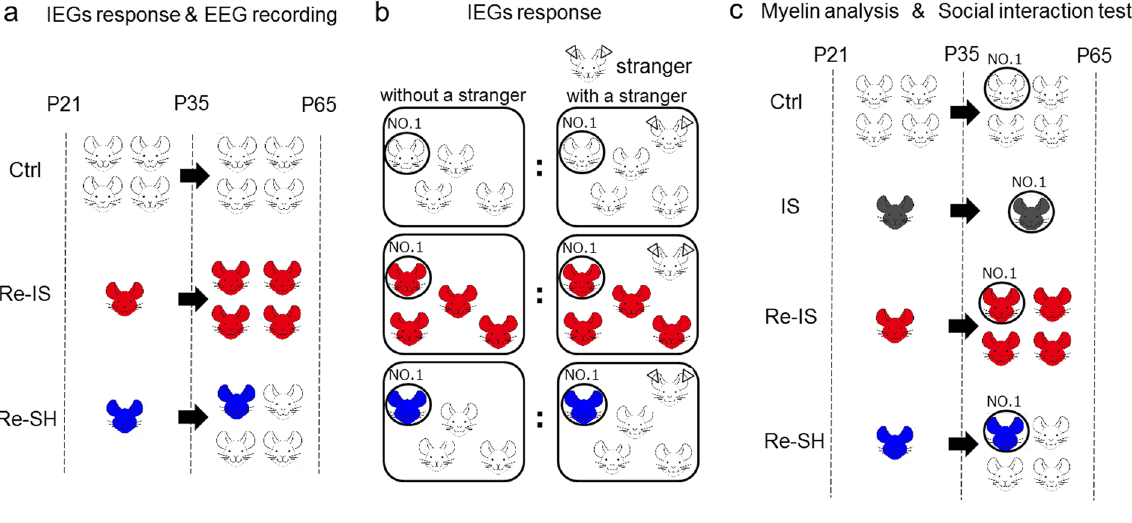
Figure 1. Experimental